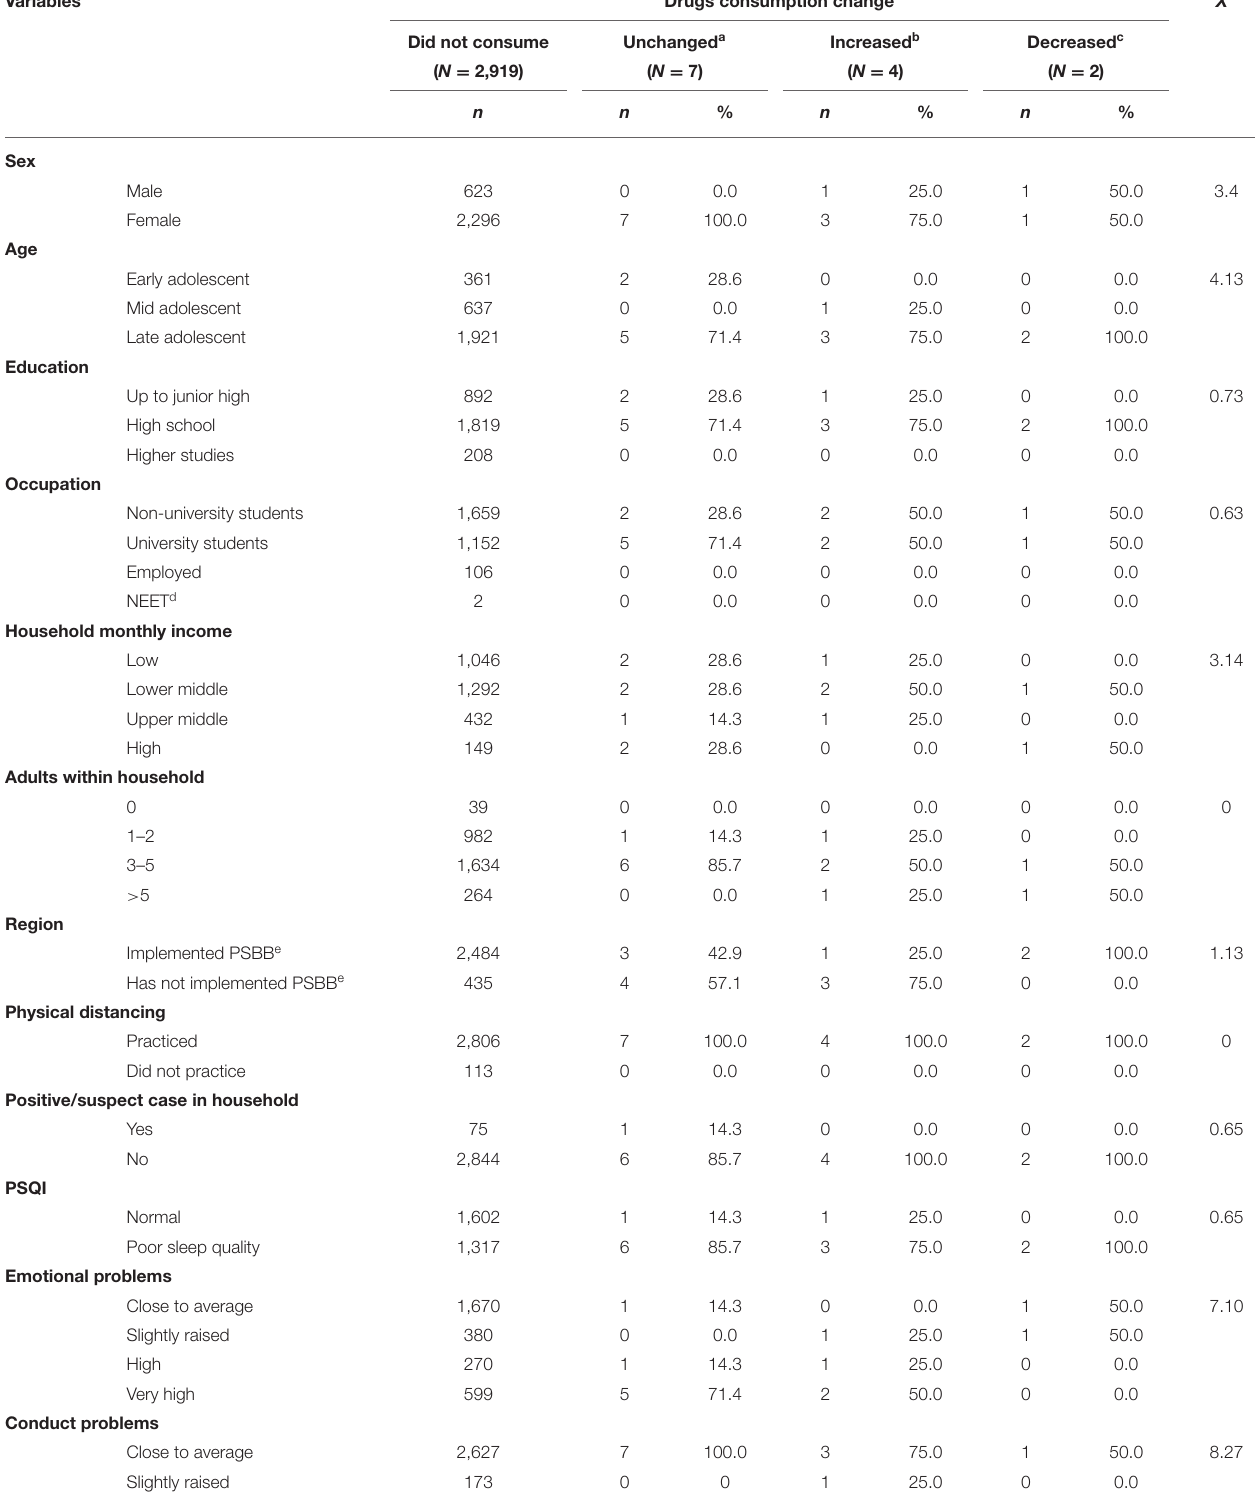
TABLE 4 | Descriptive data stratified by drug